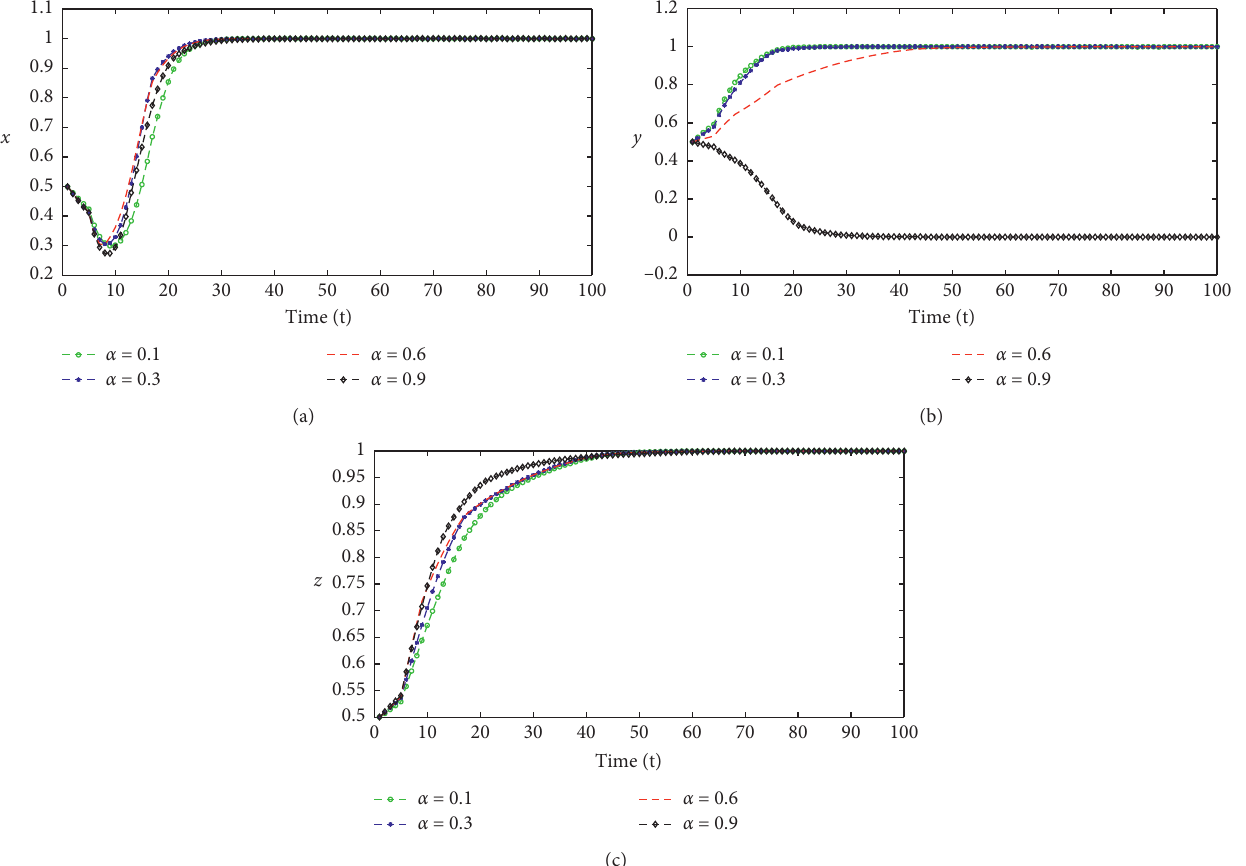
Figure 2: The effect of innovation subsidies on the evolutionary